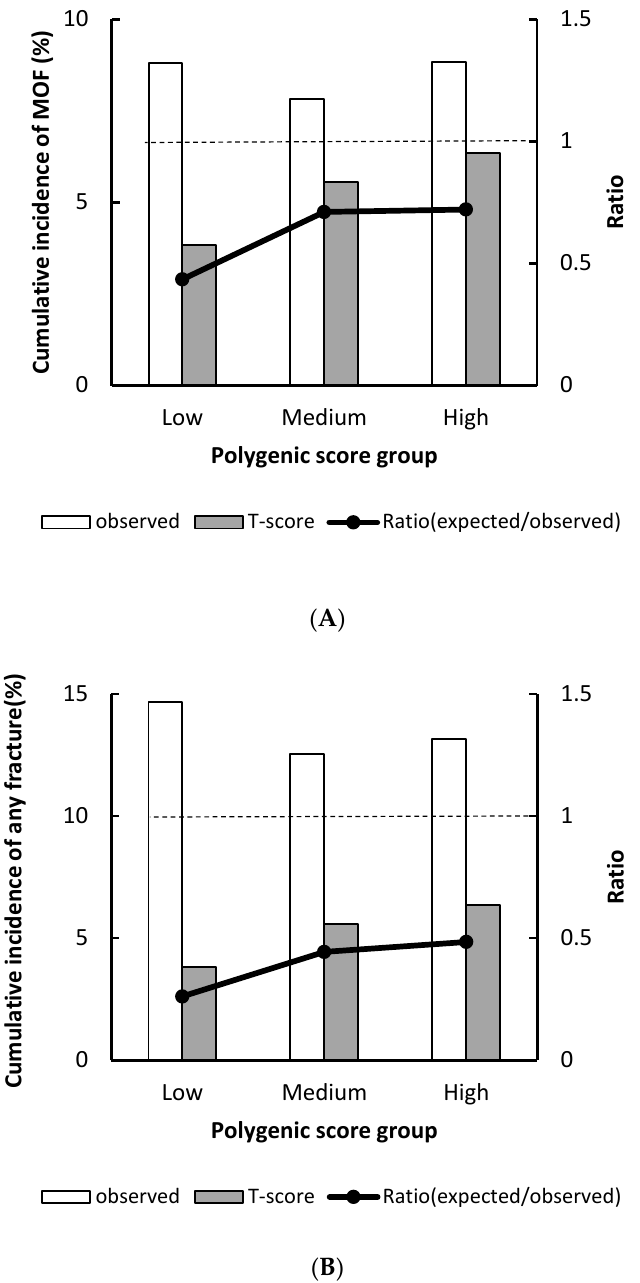
Figure 1. Observed versus predicted major osteoporotic fracture ( A ) and any fracture ( B ) probability stratified by polygenic score group. The dotted line indicates a relative ratio of 1 (reference line); ratio < 1 indicates that T-score underestimates fracture